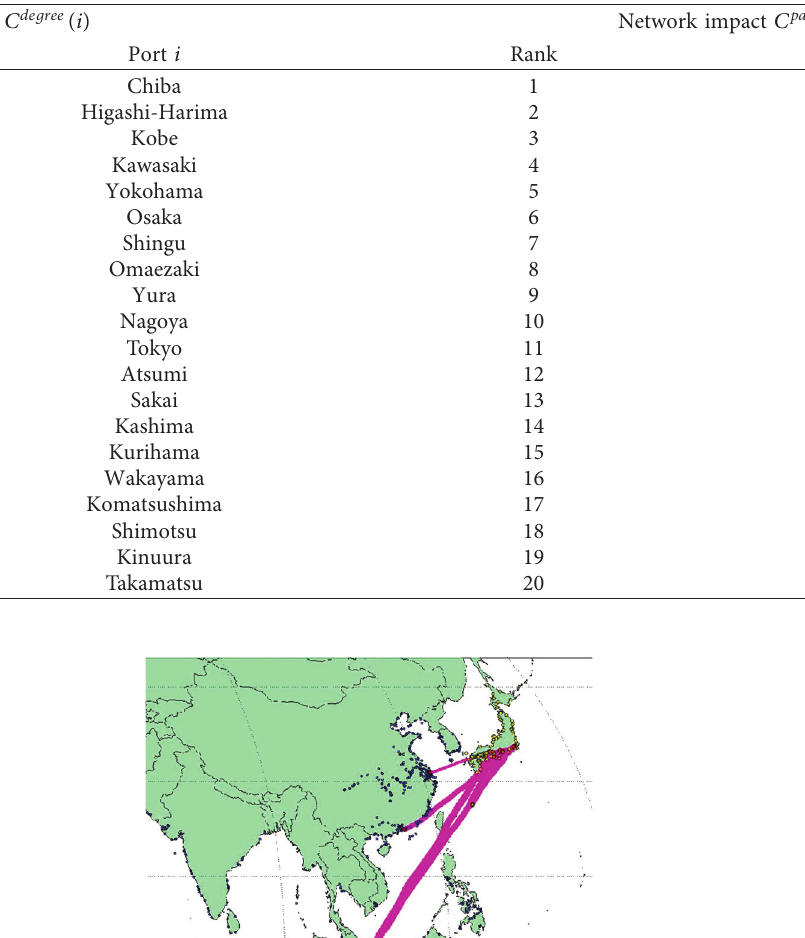
Table 9: Ranking the Japanese ports by degree and PageRank centralities.